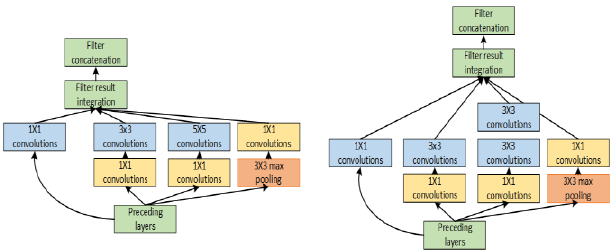
Figure 8. Inception block and improved Inception